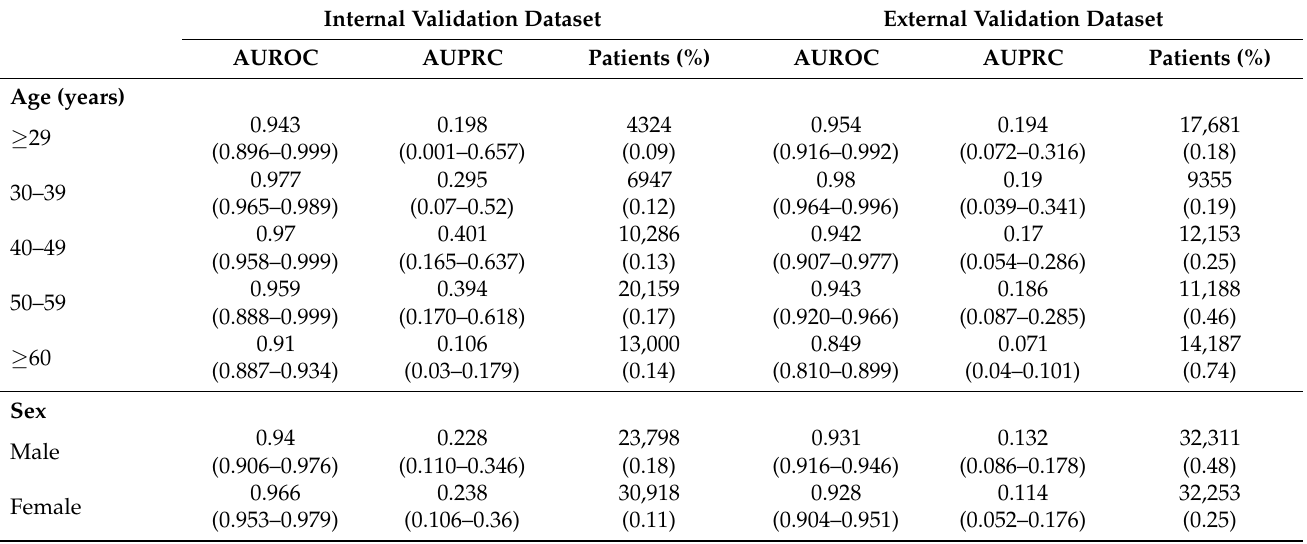
Figure 3. Calibration plot between model ‐ predicted probability and true probability. Table 3. Subgroup analysis by age and